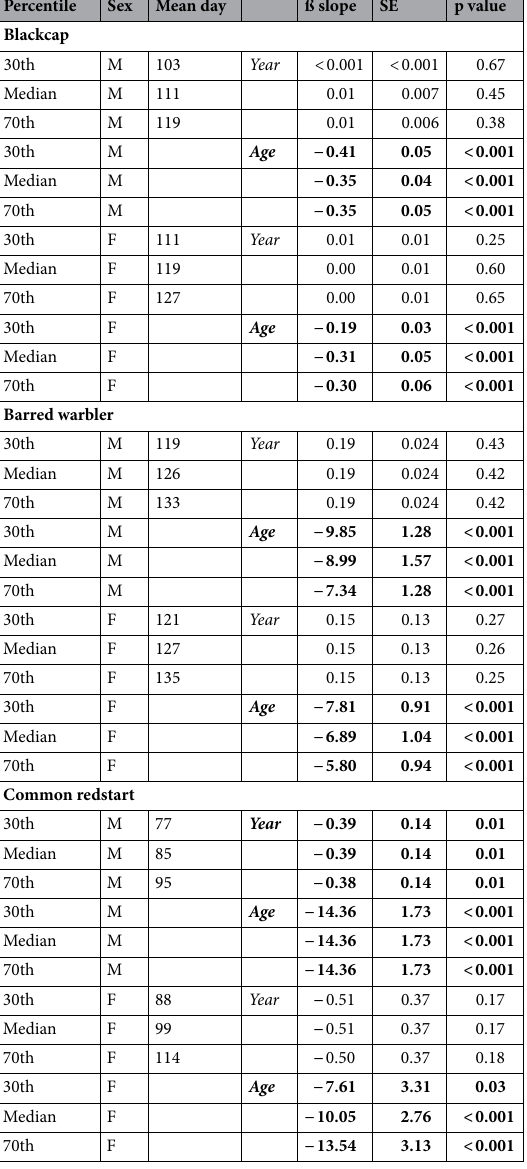
Table 3. Changes in arrival day across the study period and between age groups. The changes in first arrival day (days per year) of the three studied species to stopover site in Israel, estimated by linear quantile mixed models (first 30th percentile day, median and 70th percentile day) and the differences between age groups (adults and second year. The slope for age is relative to second year birds, i.e. negative slopes denote earlier arrival of adult birds. Mean arrival day (“Mean day”) is calculated for adults and second year birds combined. Significant results (p < 0.05) are in bold. Significant advancement of arrival is found only for male redstart. SE: standard